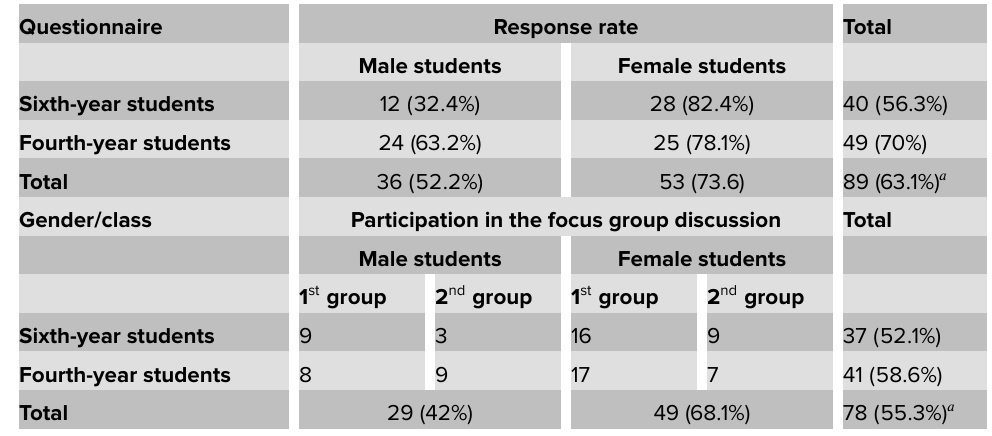
TABLE 1: Questionnaire response rate, number, and groups of the students’ focus group discussion sessions ( N = 89).